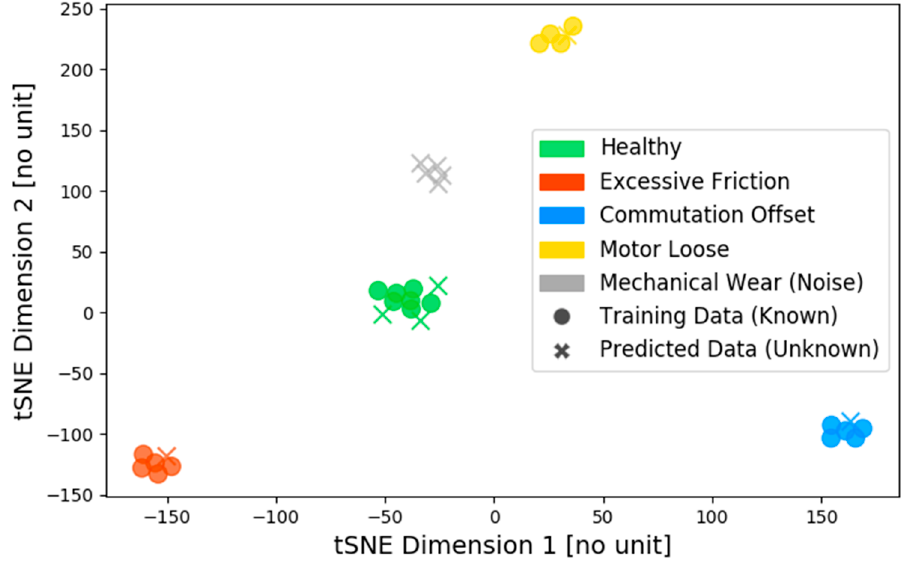
Figure 6. tSNE-plot of training and prediction with HDBSCAN.